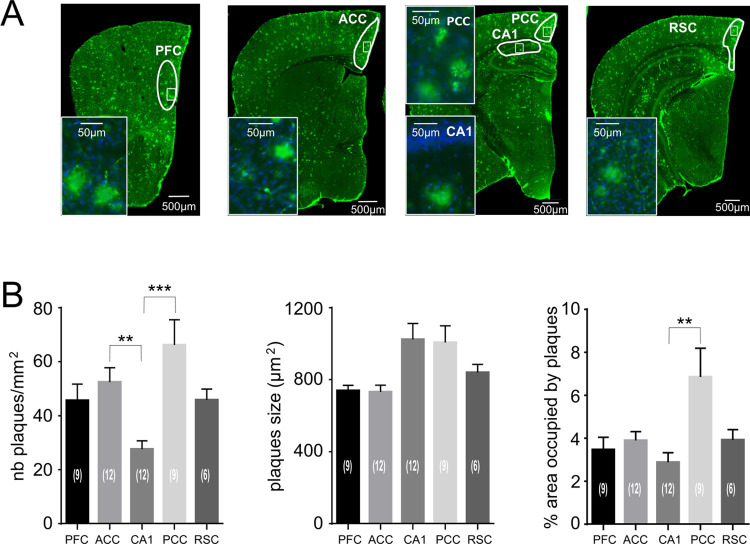
β-amyloid plaque pathology in coronal slices of APPxPS1 mice brains.β A, Anti-Aβ 1–42 immunoreactivity (6E10 + poly18058 antibodies) in coronal slices of APP/PS1 mice brains. Regions of interest are drawn in white. The inserts show higher magnification of regions delimitated by small white rectangles. Cell nuclei counterstained with Dapi (in blue). Notice that Dapi staining shows that cell nuclei are surrounding the plaques. B, Bar graphs illustrating the statistical analyses of the number of plaques (left), plaque size (middle) and area occupied by plaques (right) in the regions of interest (PFC, ACC, CA1, PCC, RSC). Notice more numerous and larger plaques in PCC versus other regions. Dunn’s test of multiple comparisons were used for statistical analyzes, ** p < 0.01, *** p < 0.001.